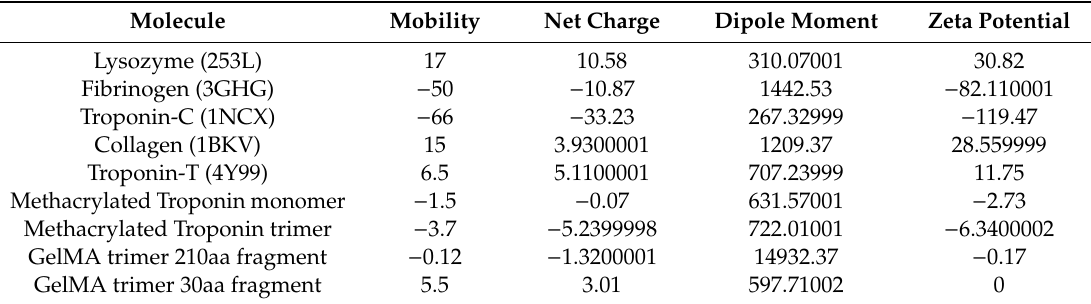
Table 2. Additional structure-based molecular